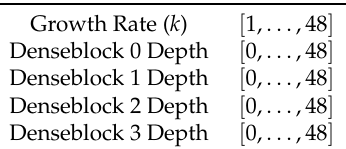
Table 1. The parameters of the DenseBlock convolutional architecture to be